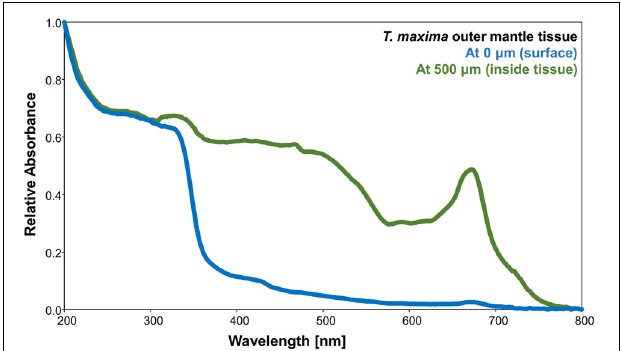
FIGURE 4 | Relative absorbance of wavelengths between 200 and 800 nm of T. maxima outer mantle tissues for two different tissue depths: outermost surface tissues (blue) and inside the tissues, at a depth of about 500 µ m from the surface